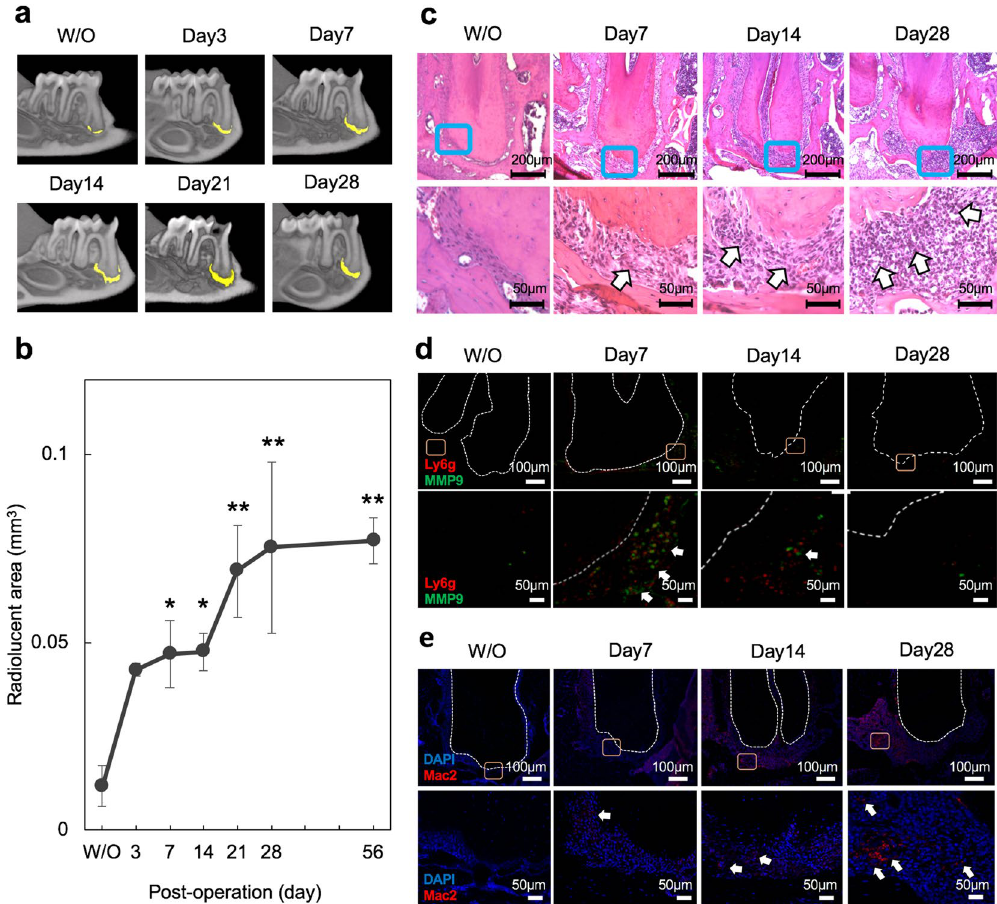
Figure 1. Establishment of a mouse AP model and analysis of lesion formation over time. ( a ) Representative μCT images of AP development in the mouse model until 28 days after pulp exposure. The radiolucent area is indicated by the yellow color and was determined using TRI/3D-BON software. ( b ) Quantitative analysis of the radiolucent area (mm 3 ) from the μCT images. Statistical analysis was done using the Dunnett test to compare group with and without (W/O) exposure; *p < 0.05, **p < 0.01 (mean ± SD, n = 3 per group). ( c ) HE staining of AP development in the mouse model until 28 days after pulp exposure. The arrow denotes inflammatory cell filtration. ( d ) Representative images showing the immunostaining of Ly6g- and MMP9-positive neutrophils (arrows). ( e ) Representative images showing the immunostaining of Mac2-positive macrophages